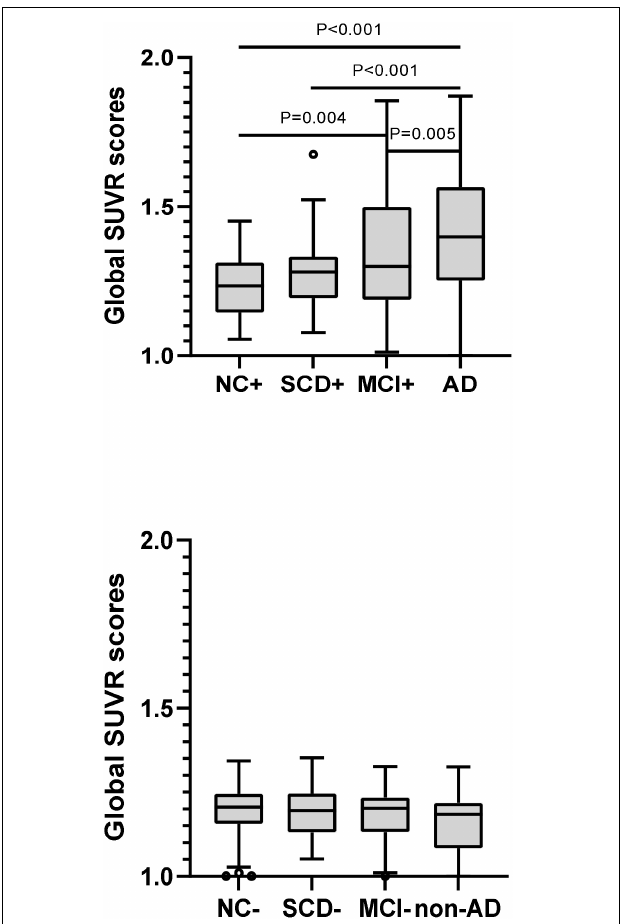
FIGURE 3 | Pairwise comparisons of global SUVR scores over the course of cognitive decline in participants with A β -PET (+) and A β -PET (–). P -values were adjusted for age, sex, and education years. The black circles represented the